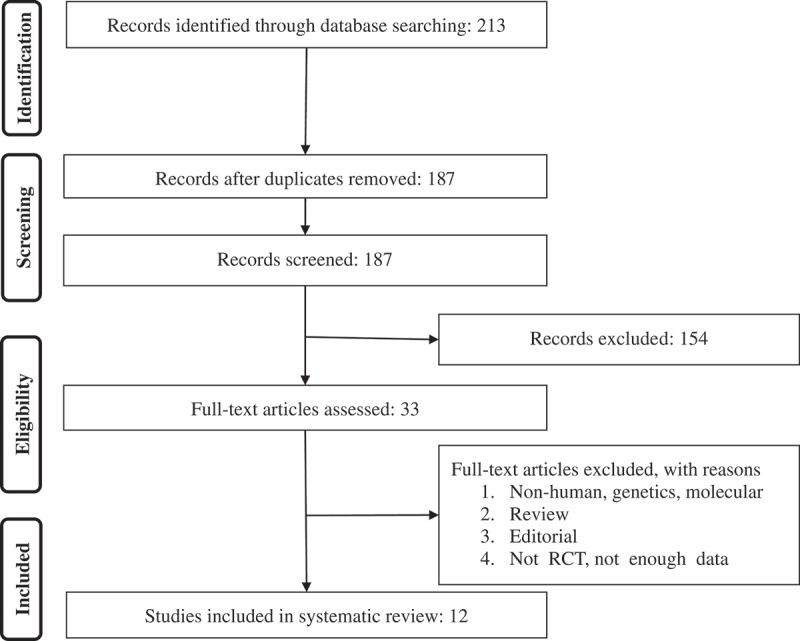
PRISMA flow chart for the studies selection.